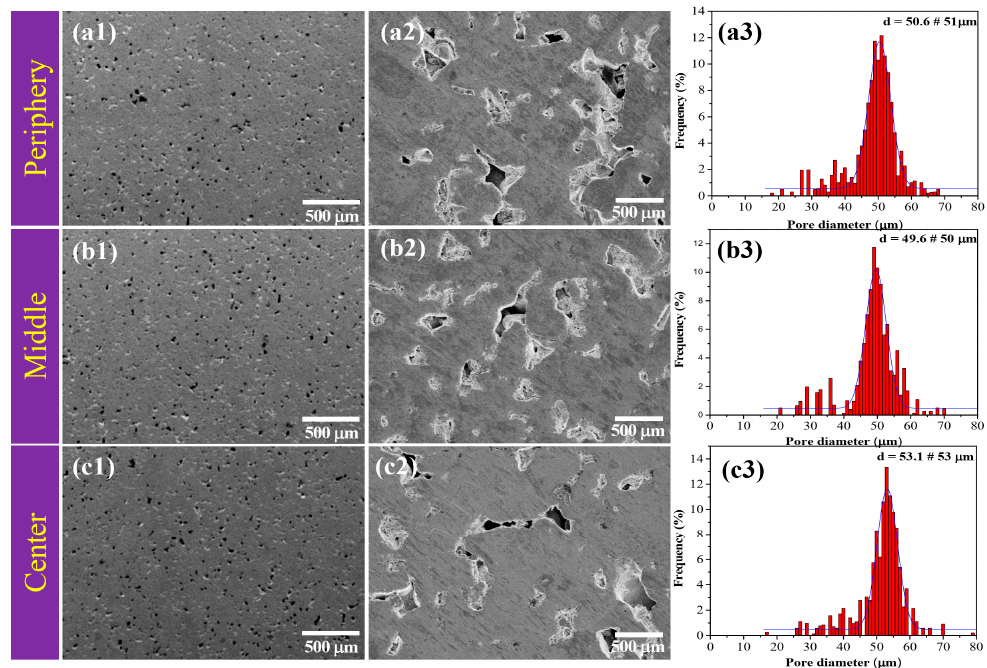
Figure 3. SEM images and pore size distribution of Ti6Al4V alloy sintered by vacuum sintering at different positions: ( a1 , a2 , a3 ) periphery, ( b1 , b2 , b3 ) middle, and ( c1 , c2 , c3 ) center of the specimen.